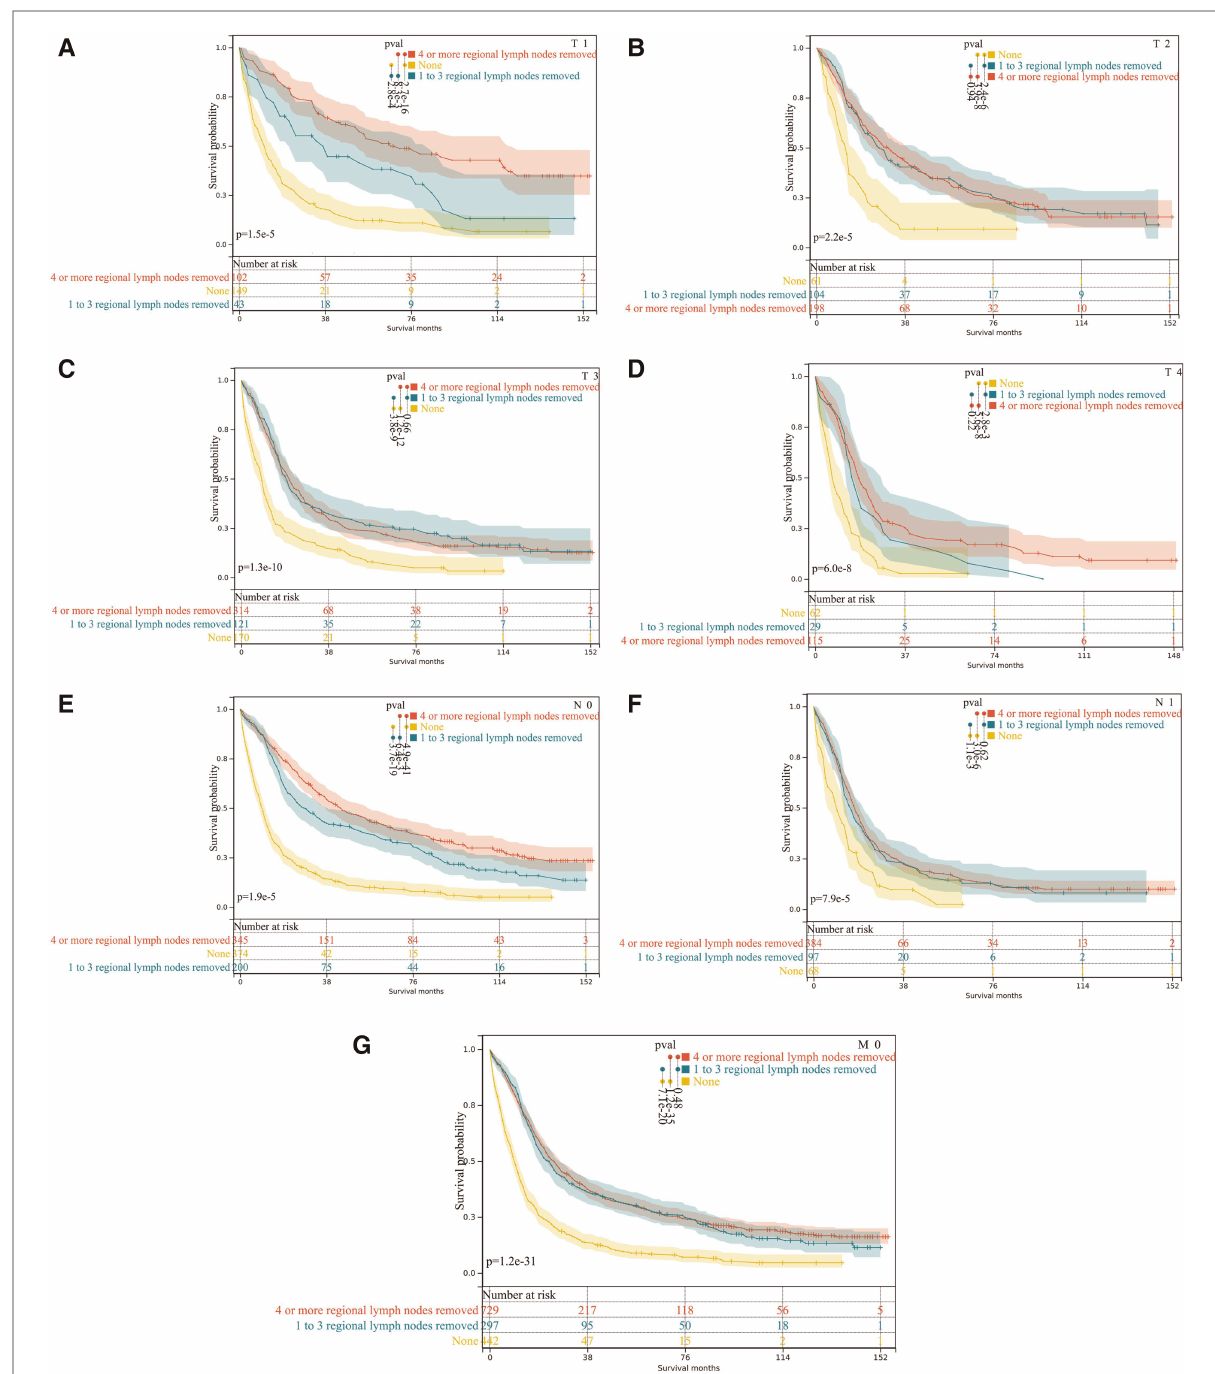
FIGURE 5 Subgroup analysis of lymph node dissection in M0 pCCA patients by Kaplan-Meier curves. ( A – D ) T1-T4; ( E,F ) N0 and N1; ( G ) the subgroup of